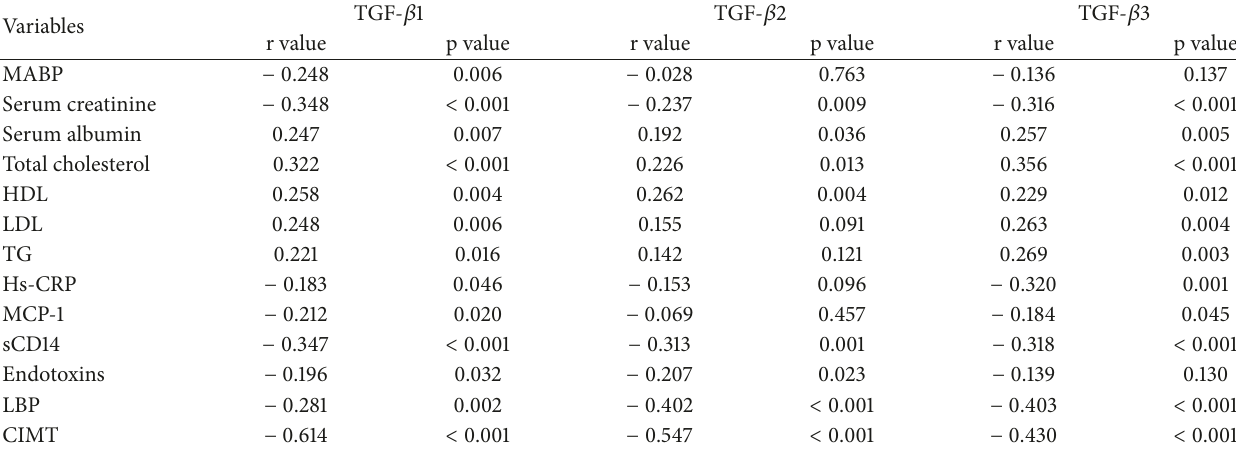
Table 2: Correlation between transforming growth factor 𝛽 isoforms, renal function, lipoprotein particles, inflammation, and markers of atherosclerosis.